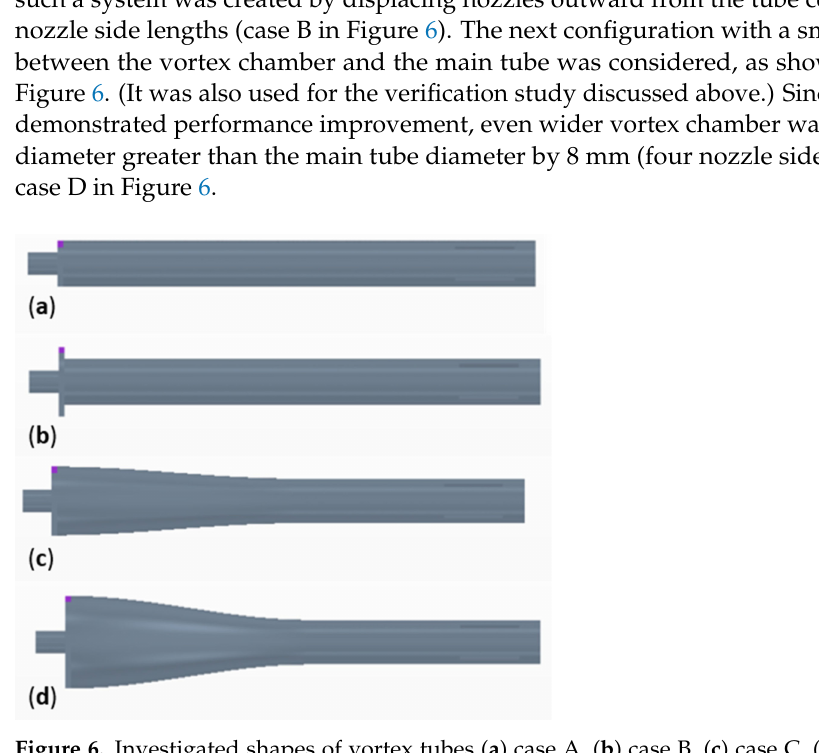
Figure 6. Investigated shapes of vortex tubes ( a ) case A, ( b ) case B, ( c ) case C, ( d ) case D. Purple square dot in the top left corner of each configuration indicates one of four inlet